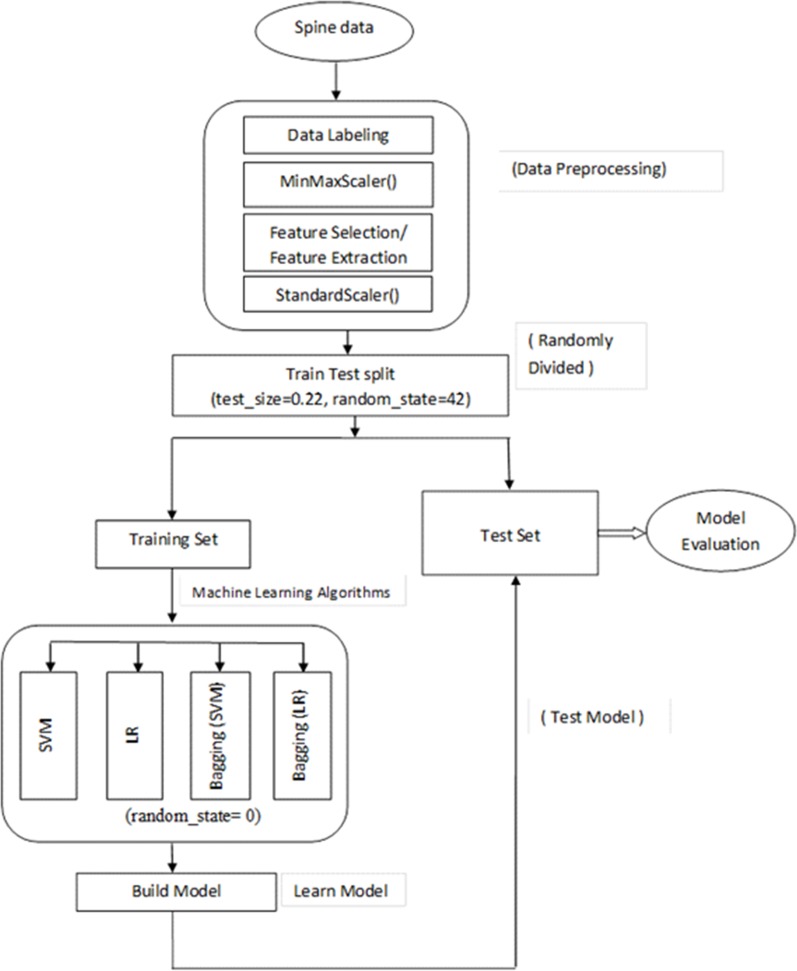
Work flow diagram.